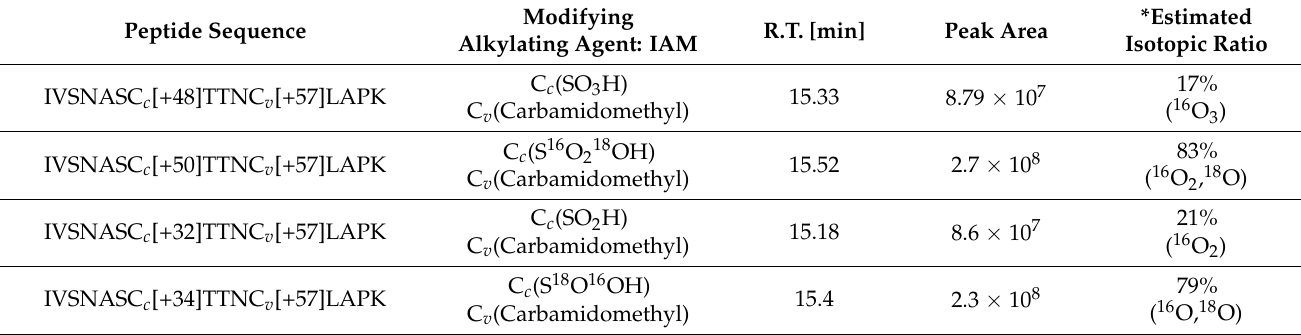
Table 1. Mass Spectrometry of modifications to the H 2 O 2 − oxidized tryptic peptide fragment of r − GAPDH subunits. ( a ) The active site cysteine residue LC/MS/MS data of (C7, C c (SH)